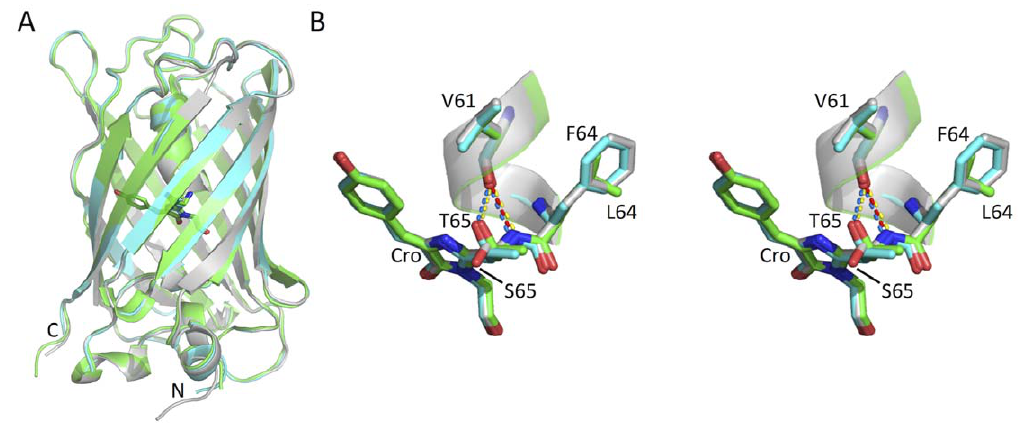
Figure 3. Structural comparison of wt GFP, S65T GFP and EGFP. (A) overlay of EGFP (green), wt GFP (grey) and S65T GFP (cyan). (B) Stereo view of the influence of the S65T mutation on local hydrogen bond network. EGFP, wt GFP and S65T GFP coloured as in A. Hydrogen bonds associated with EGFP, wt GFP and S65T GFP are yellow, red and blue dashed lines respectively.